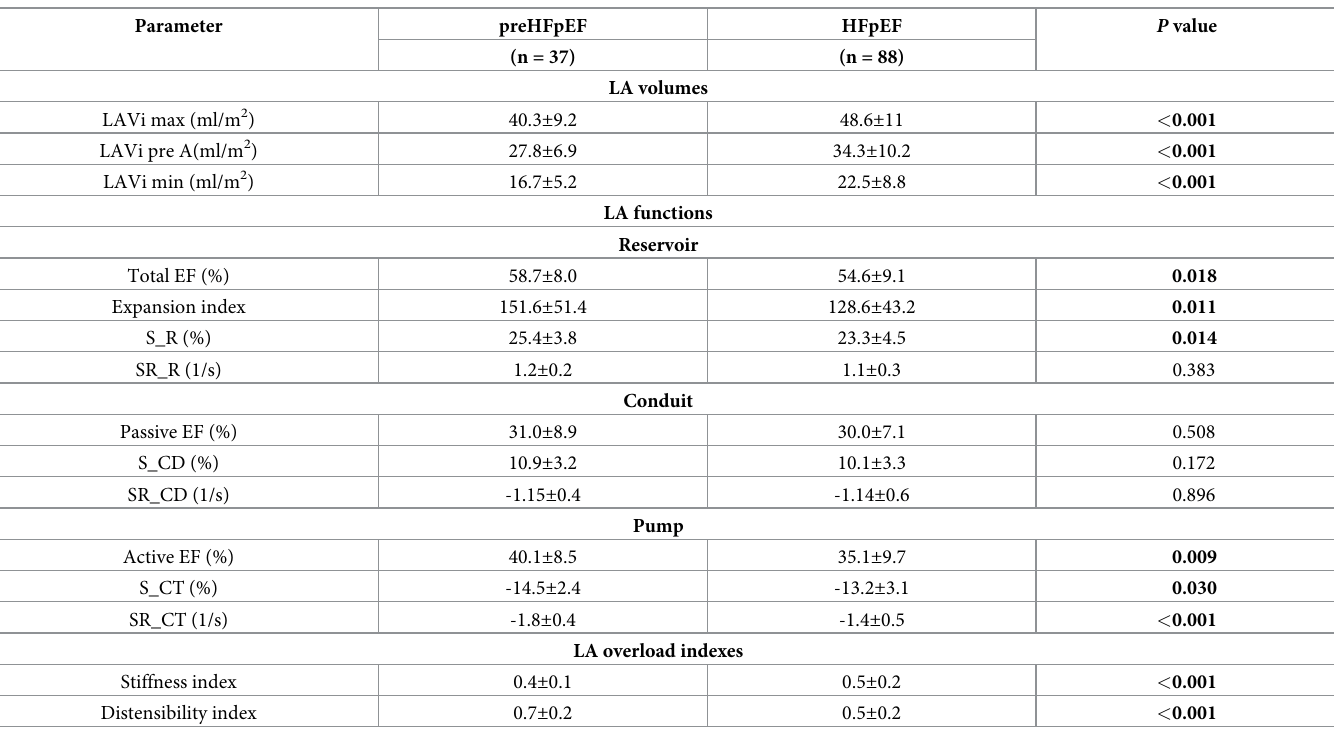
Table 3. Left atrial volumes and functions.